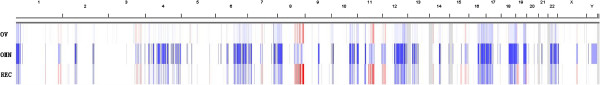
Copy number variants in the ovarian tumors. Filtered CNVs in the OV, OMN, and REC tumors across the genome, with chromosomal labels at the top. Because we are only interested in large scale deletions and amplifications, smaller CNV calls were removed and adjacent segments were merged. In the heat map, red indicates amplifications and blue indicates deletions. The magnified CNV patterns from OV, to OMN, to REC are likely due to differences in tumor purity. Notable amplifications are seen in 8q and 11q. Deletions are seen in chr4, 6q, 7q, 12q, 16q, chr17, chr19, chr22.